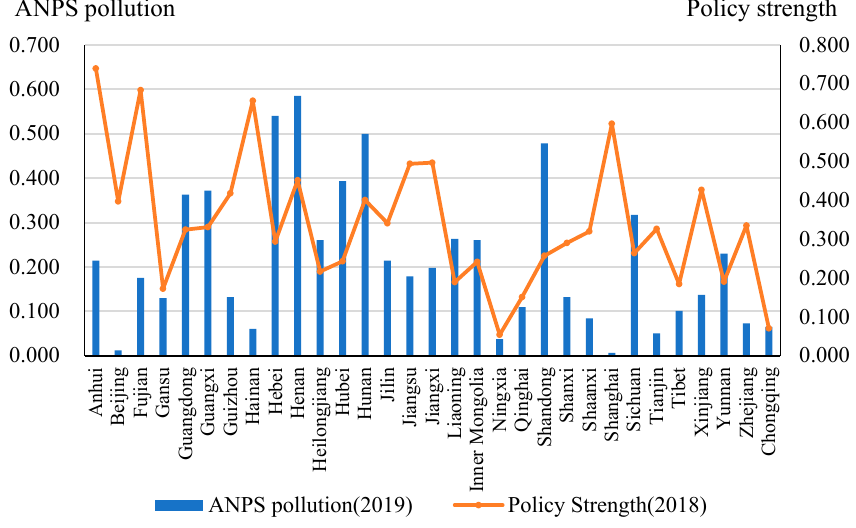
Figure 9. Policy strength in 2018 and ANPS pollution emissions in 2019.